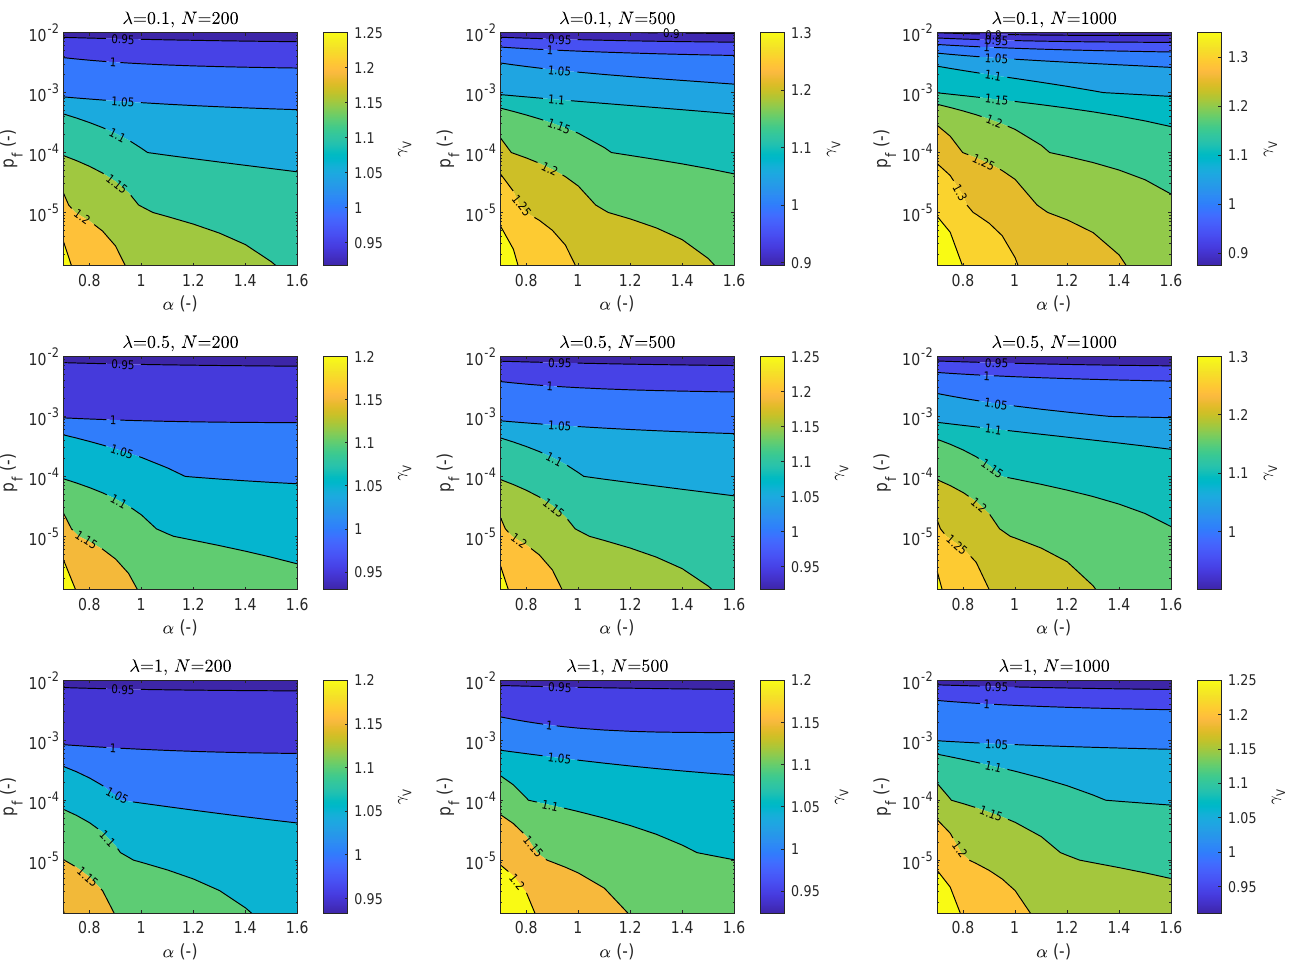
Figure A4. Partial safety factor related to the velocity, γ v , for variable failure probabilities considering a reference block mass having a return period T k = 200